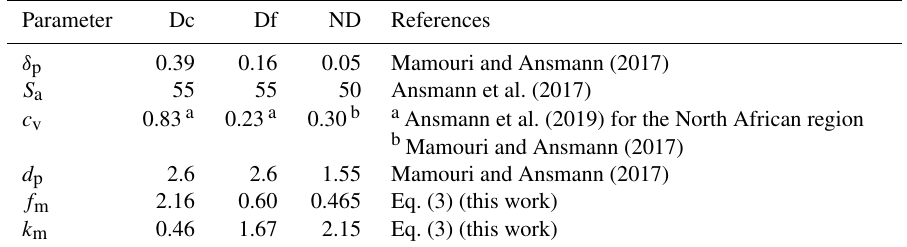
Table 1. Assumed specific values of PLDR ( δ p ) and LR ( S a , sr), together with the mass conversion factor ( f m , gm − 2 ), particle density ( d p ,